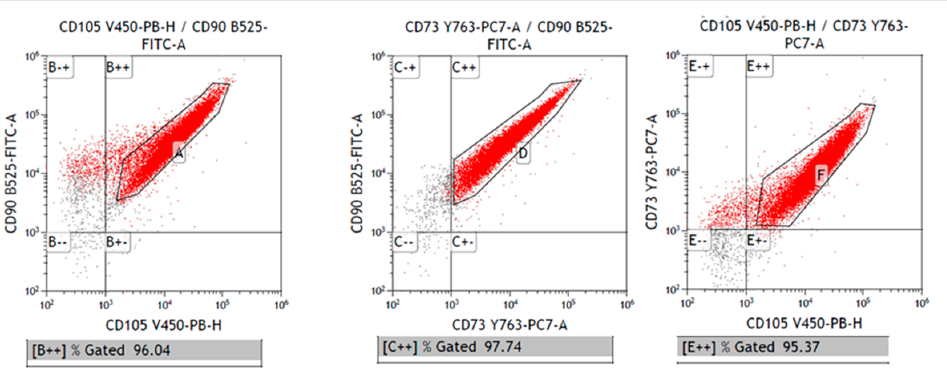
Figure 3. Representative bivariate dot plots. The phenotyping of the Mesenchymal Stem Cells (MSCs) by flow cytometry identified the expression of the surface proteins CD90 and CD105 in 96.04%, positive for both CD90 and CD73 in 97.74% and for CD73 and CD105 in 95.37%.